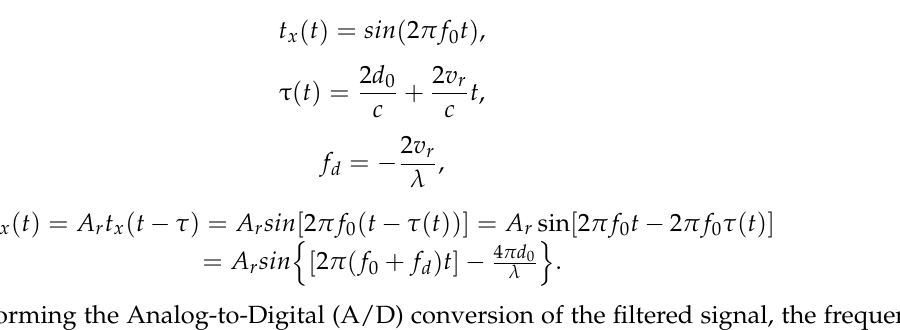
Figure 1. Continuous Wave (CW) Doppler radar architecture.